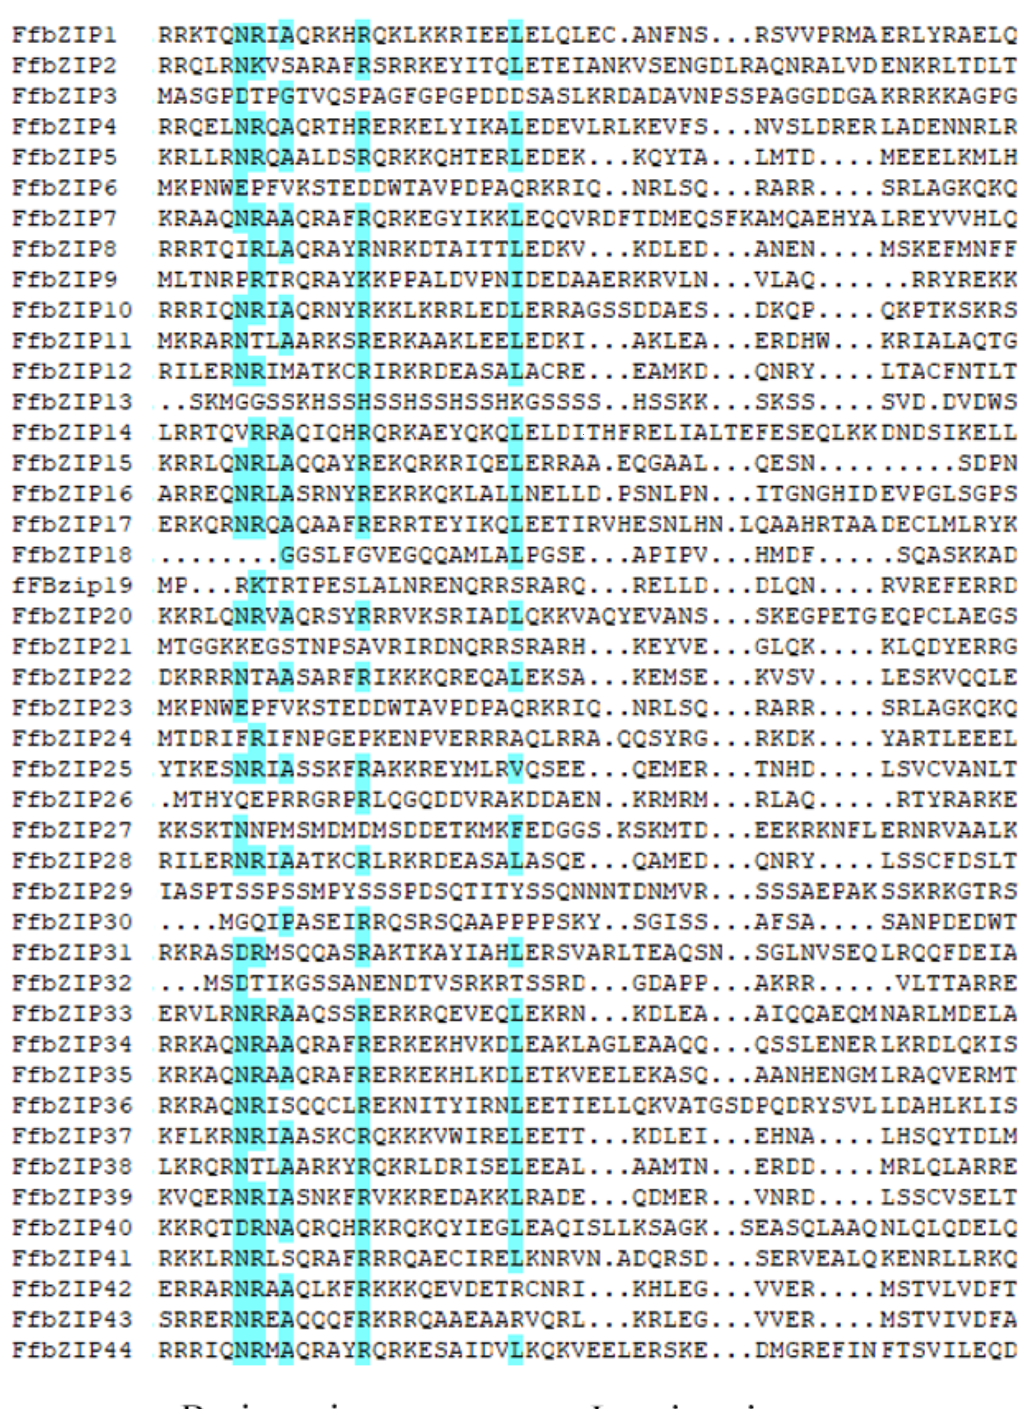
Figure 2. Sequence alignment of FfbZIP domains.